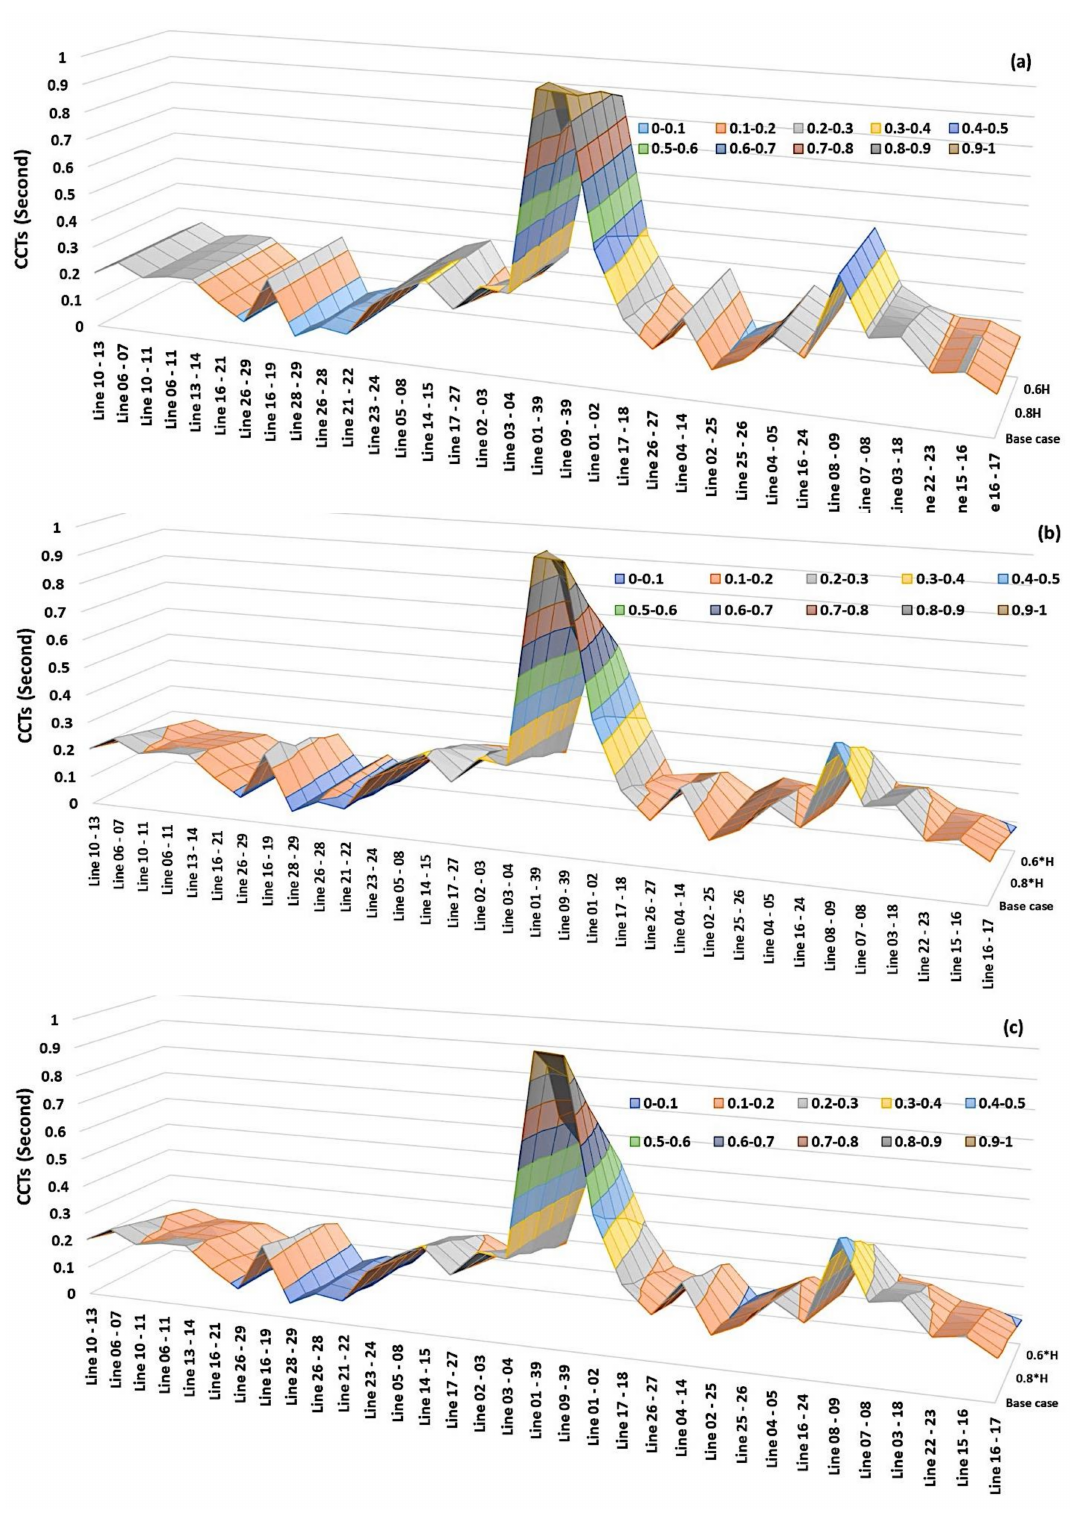
Figure 2. Sensitivity analysis of inertia constant with the CCTs at transmission lines for three scenarios ( a ), ( b ) and ( c